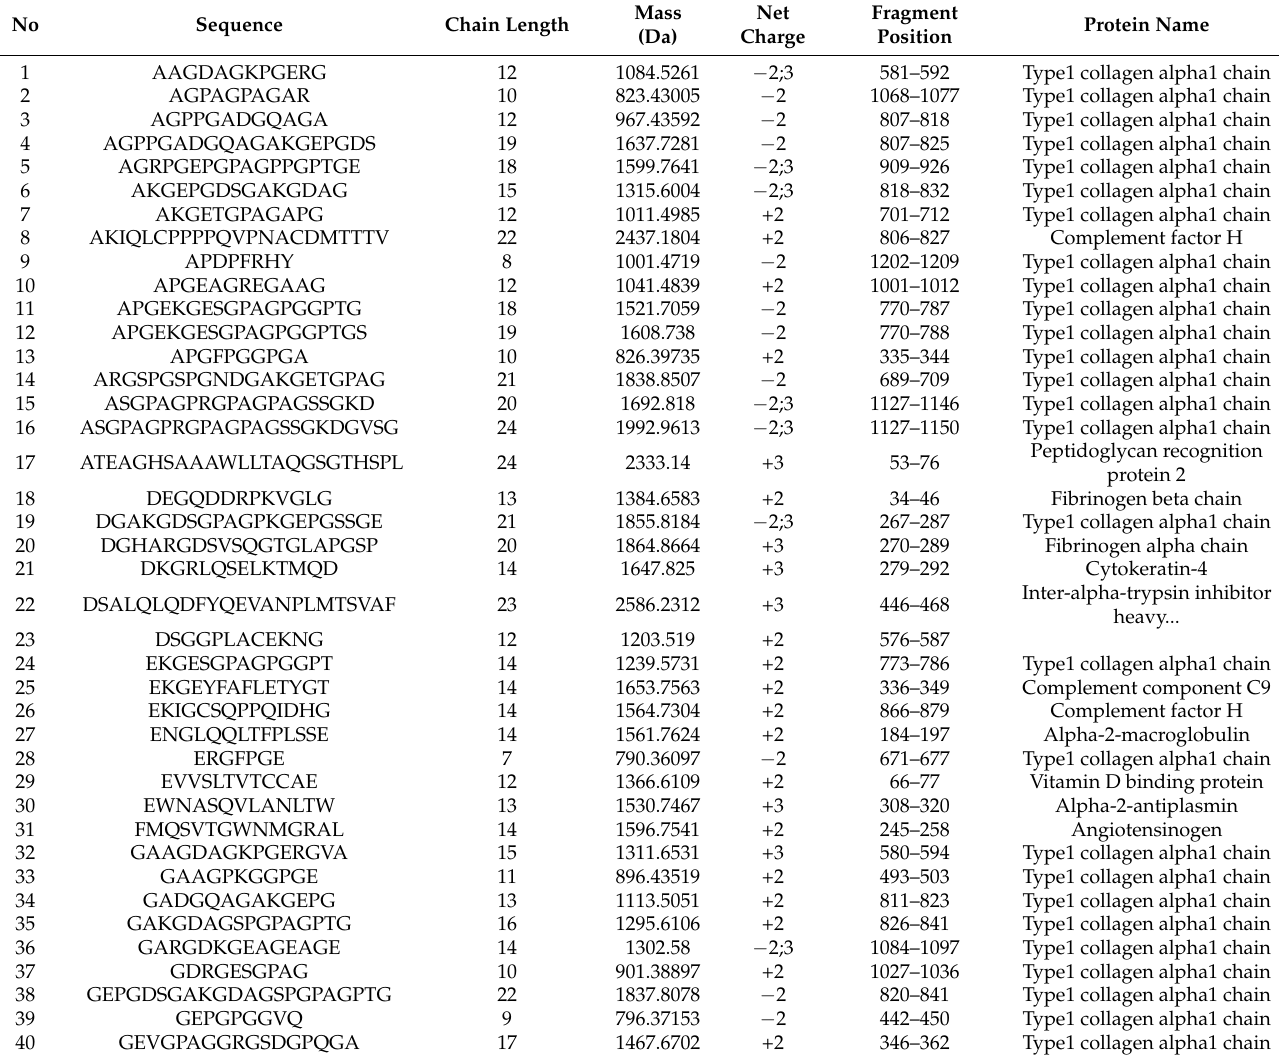
Table 4. Collagen peptides identified in the acetone fraction of the hydrolysate produced with